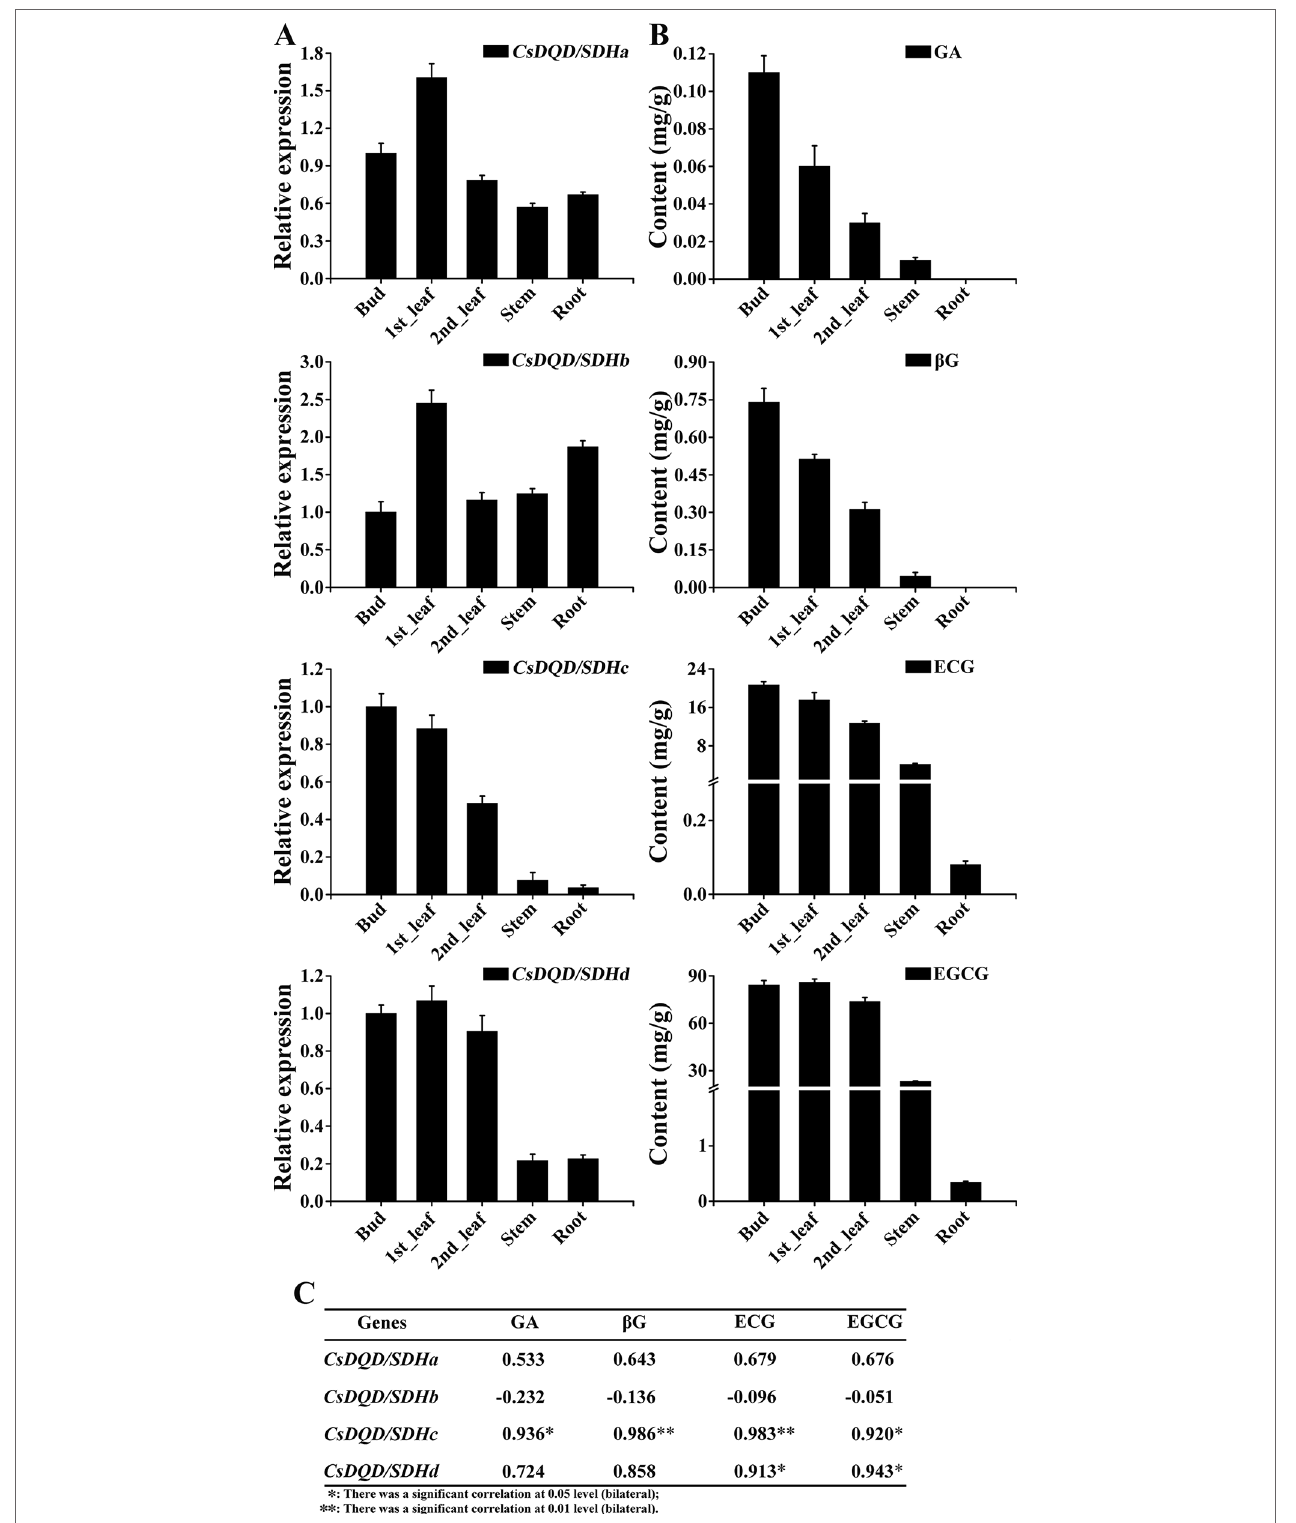
FIGURE 7 | Expression patterns of four CsDQD/SDH genes and the accumulation profiles of GA and its derivatives in different tissues of tea plants. (A) Expression profiles of the CsDQD/SDHa , CsDQD/SDHb , CsDQD/SDHc , and CsDQD/SDHd genes in different organs. (B) Quantitative analysis of GA, β G, ECG, and EGCG contents in different tea organs. Data are presented as the means of three independent assays. (C) Analysis of the Pearson correlation coefficient of the expression pattern of CsDQD/SDHs and the content of GA, β G, ECG, and EGCG. GA, gallic acid; ECG, epicatechin gallate; EGCG, epigallocatechin